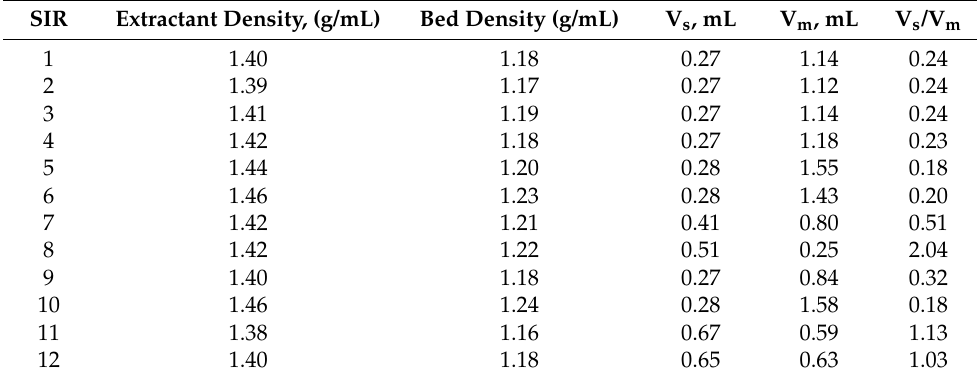
Table 7. Physical constants of columns packed with developed